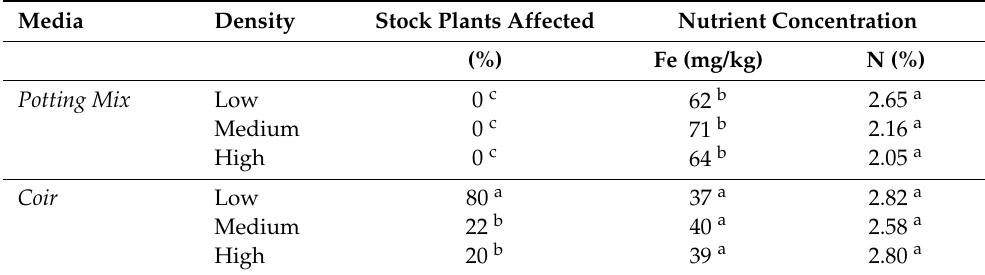
Figure 1. Plants of tea tree ( M. alternifolia) showing signs of leaf chlorosis in the middle bag after 12 months of cultivation (medium density coir). Table 1. Percentage of tea tree ( M. alternifolia) stock plants showing signs of chlorosis after 360 days with leaf tissue iron (Fe) and nitrogen (N) concentrations. Means followed by the same letter in each column were not significantly different at the 95% confidence level.